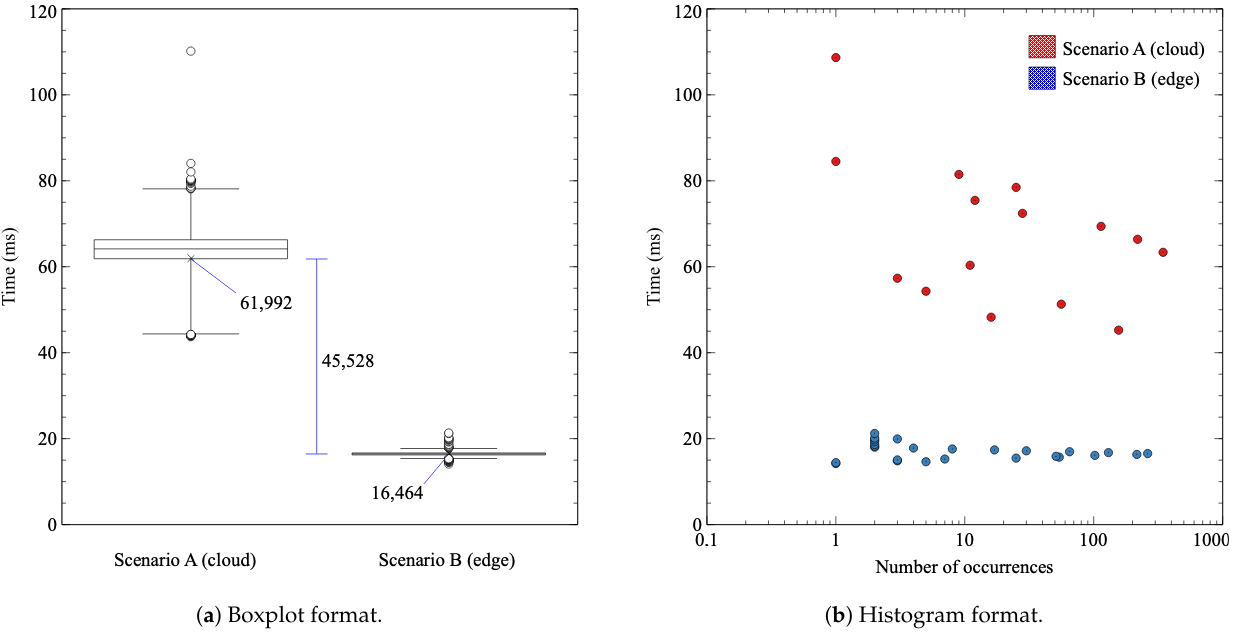
Figure 9. Latency measurement experiment for scenario A ( test 1.1, regular cloud broker) and scenario B ( test 1.2 , alarm edge